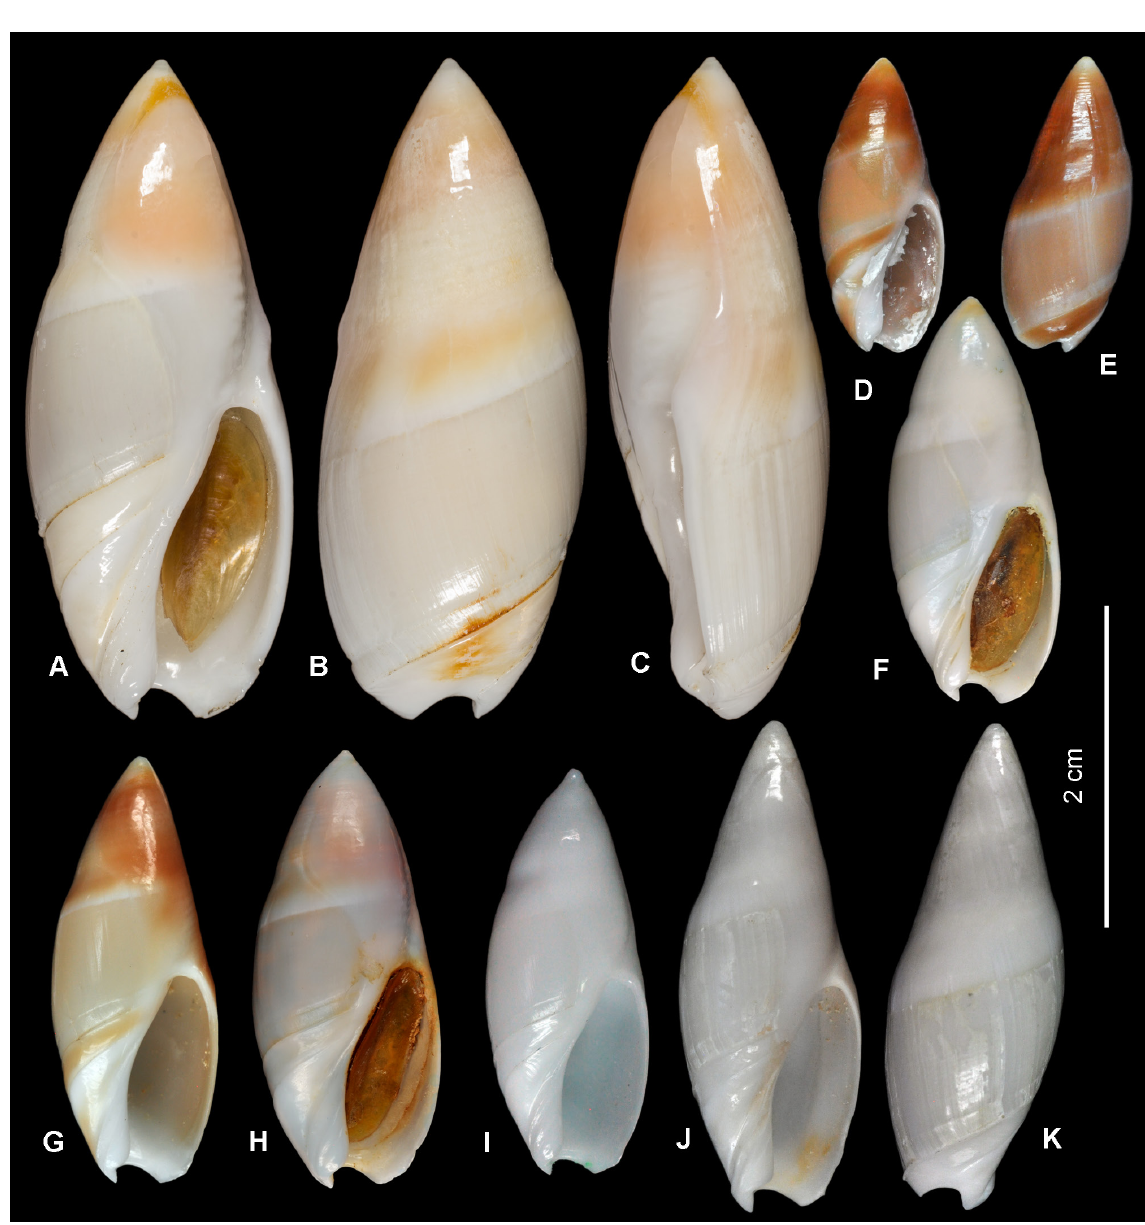
Fig. 12. Amalda montrouzieri (Souverbie, 1860), southern New Caledonia. A–C . Syntype MNHN IM- 2000-1475, SL 41.4 mm. D–E . MNHN IM-2013-80199, SL 18.7 mm (sequenced specimen). F . Secteur Île Ouen-Baie du Prony, LAGON, stn DW98, 22°35.7′ S, 166°31.8′ E, 15 m, SL 25.6 mm. G . Grand Récif Sud, LAGON, stn DW334, 22°38′ S, 166°53.6′ E, 47–48 m, SL 26.6 mm (illustrated by Kilburn & Bouchet 1988: fig. 14). H . Secteur de Nouméa. LAGON, stn DW51, 22°14.7′ S, 166°11.1′ E, 10 m, SL 27.6 mm. I . Grand Récif Sud, LAGON, stn DW544, 22°50.8′ S, 166°48.5′ E, 25 m, SL 25.4 mm. J–K . A. cf. montrouzieri . Deep-water morph, SMIB2, stn DW23, 22°31′ S, 167°37′ E, 410–420 m, SL 30.2 mm (specimen illustrated by Kilburn & Bouchet 1988: figs 5–6). All specimens except D–E not sequenced. Shells at the same